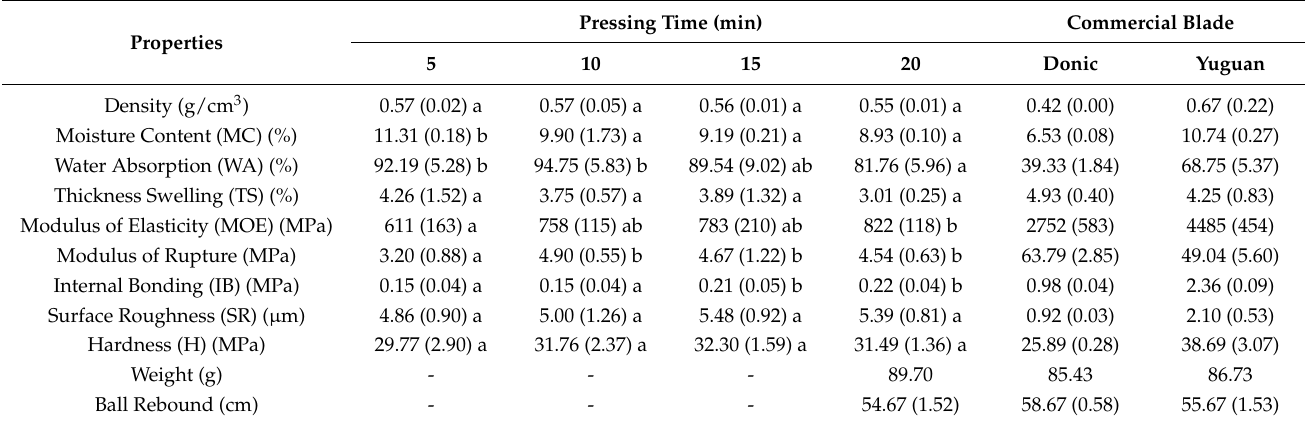
Table 3. Properties of TTBSB-particleboards at different pressing